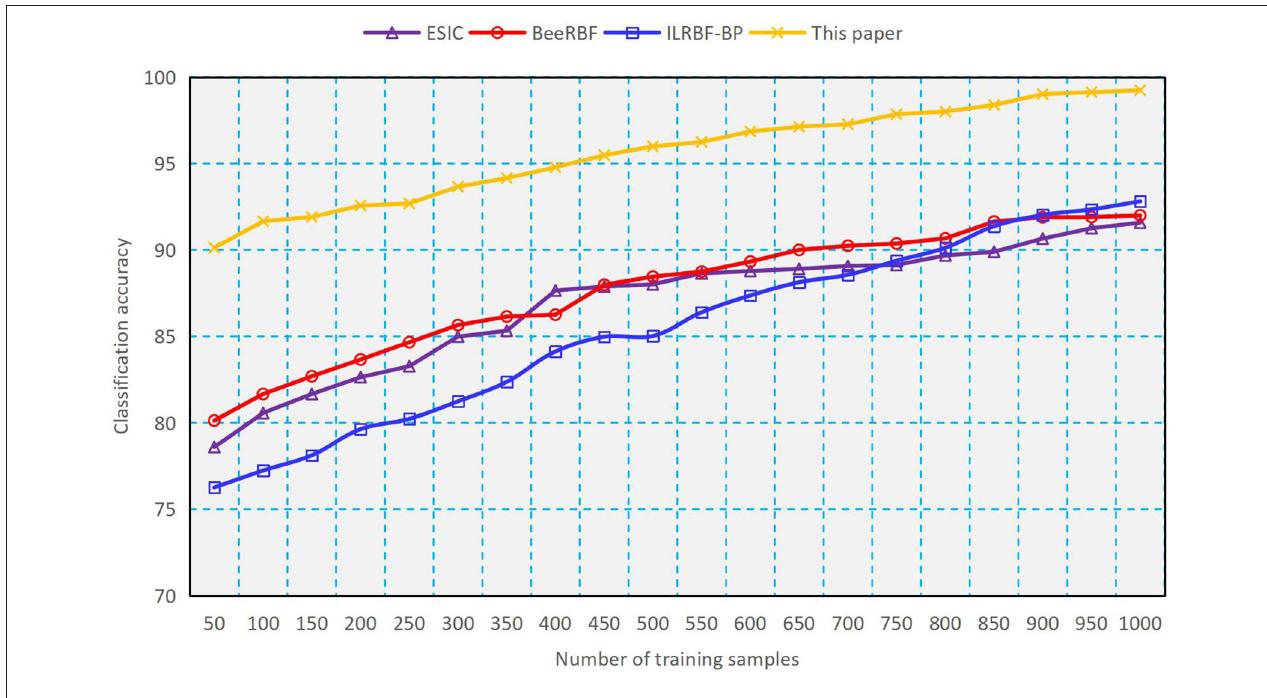
FIGURE 2 | Performance of classification accuracy.